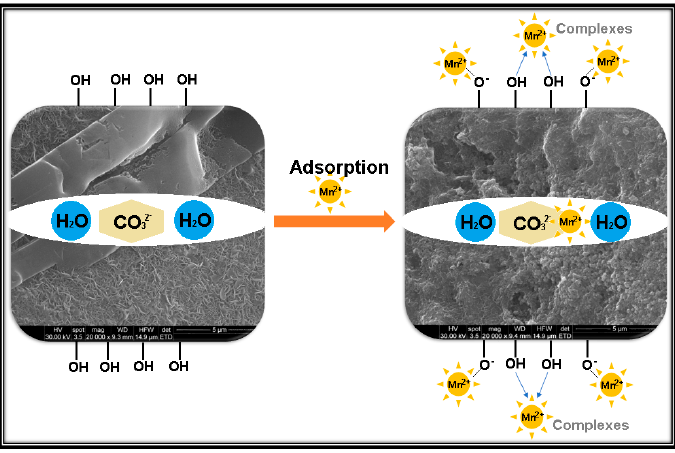
Figure 8. Schematic representation of the possible adsorption mechanism of Mn 2+ onto Mg-Al LDH.